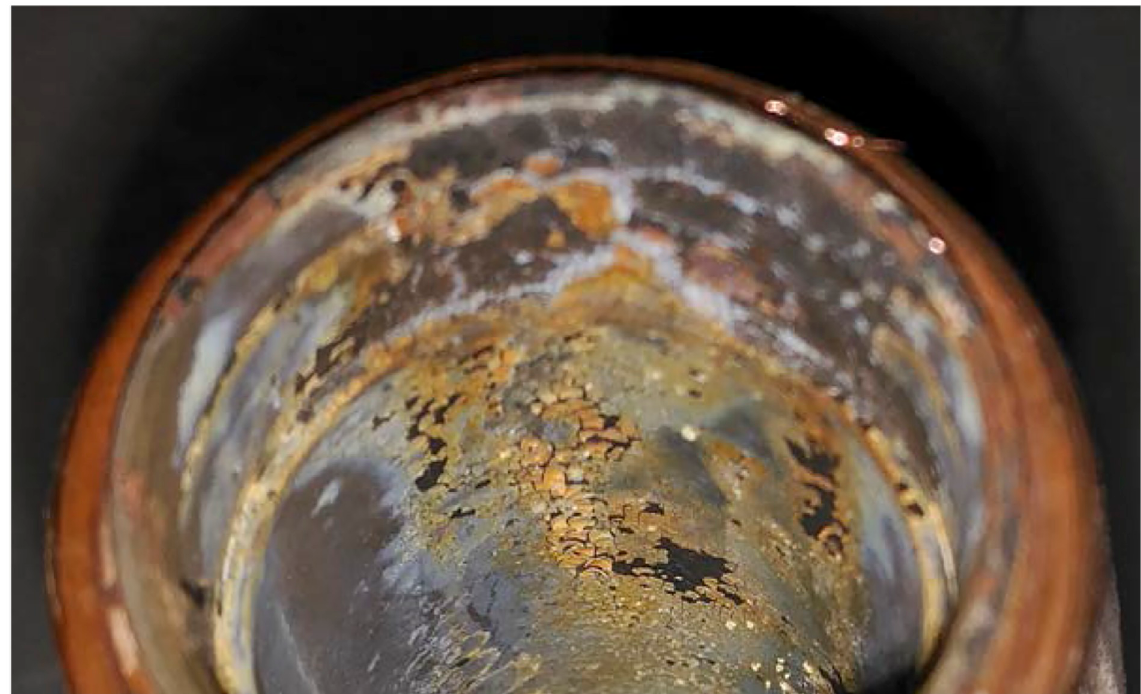
Fig 7. Nanoparticle deposition after the efficiency tests.